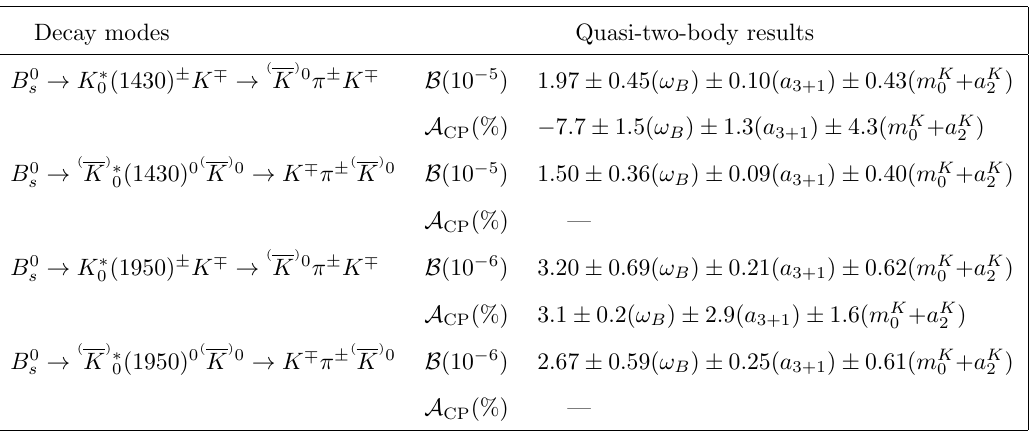
Table 5 . PQCD predictions of the CP averaged branching fractions and the direct CP asymme- tries for the combined decays B 0 intermediate